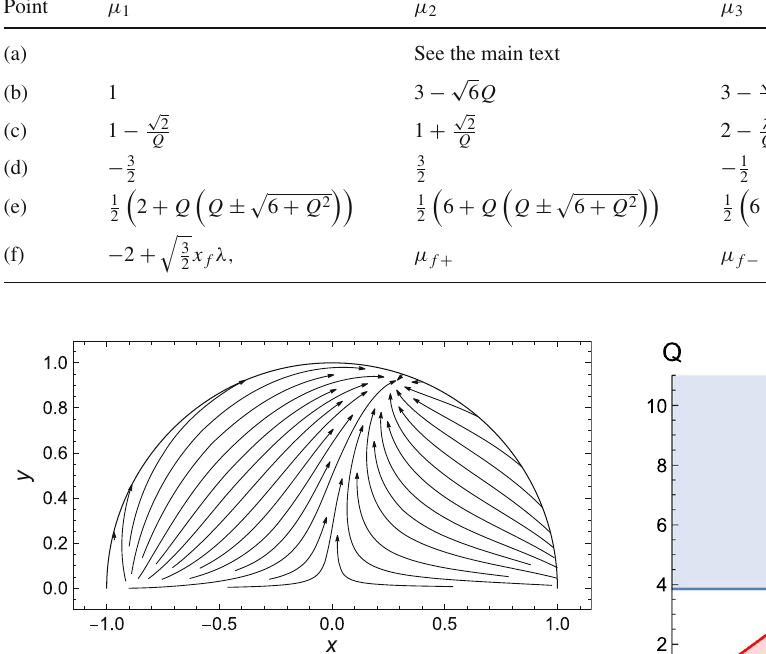
Fig. 1 Phase plane for the fixed point (f) with λ = 1 and Q = 1 / 4 saddle point. Similar results are found for other values of λ and Q .